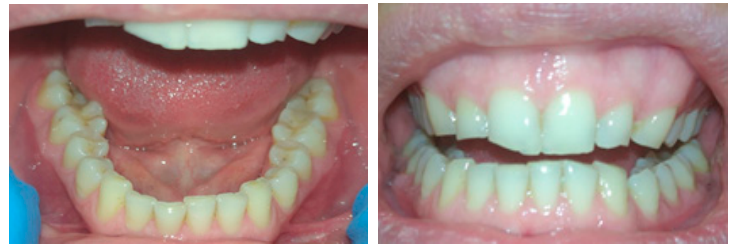
Figure 1. A patient 35 years old with bruxism. Tooth wear with attrition